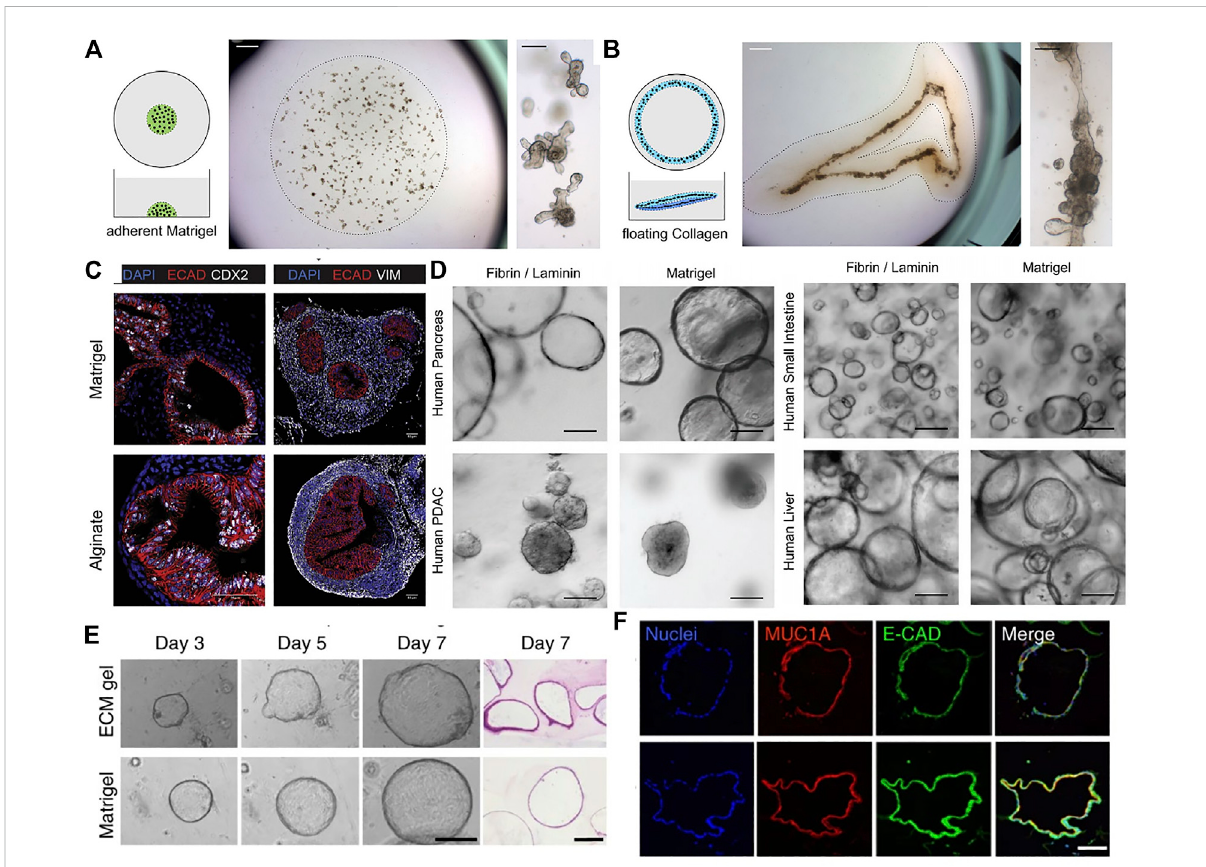
FIGURE 1 Theuseofdifferentnaturally-derivedhydrogelsforculturingepithelialorganoids. (A) Traditionalorganoidcultureinaplastic-adherentMatrigel. Mouse intestinal organoids grew as single budding cysts. (B) In vivo-like continuous tube formation of the intestinal organoids cultured in a fl oating contractingcollagenhydrogel.Adaptedfromref.(Sachsetal.,2017). (C) Immunostainingimagesofhumanintestinalorganoidsgrown inalginategel and Matrigel. Markers shown are ECAD for epithelium, CDX2 for intestinal epithelium, and VIM for mesenchyme. Adapted from (Capeling et al., 2019). (D) Bright- fi eld images of various types of human epithelial organoids grown in fi brin hydrogel supplemented with laminin and in Matrigel. Adapted from ref. (Broguiere, et al., 2018). (E) Bright- fi eld and H&E images of human pancreatic organoids cultured in porcine intestinal tissue- deriveddecellularizedECM hydrogel andMatrigel. (F) Immuno fl uorescenceanalysisofthepancreaticorganoidsshowing expression